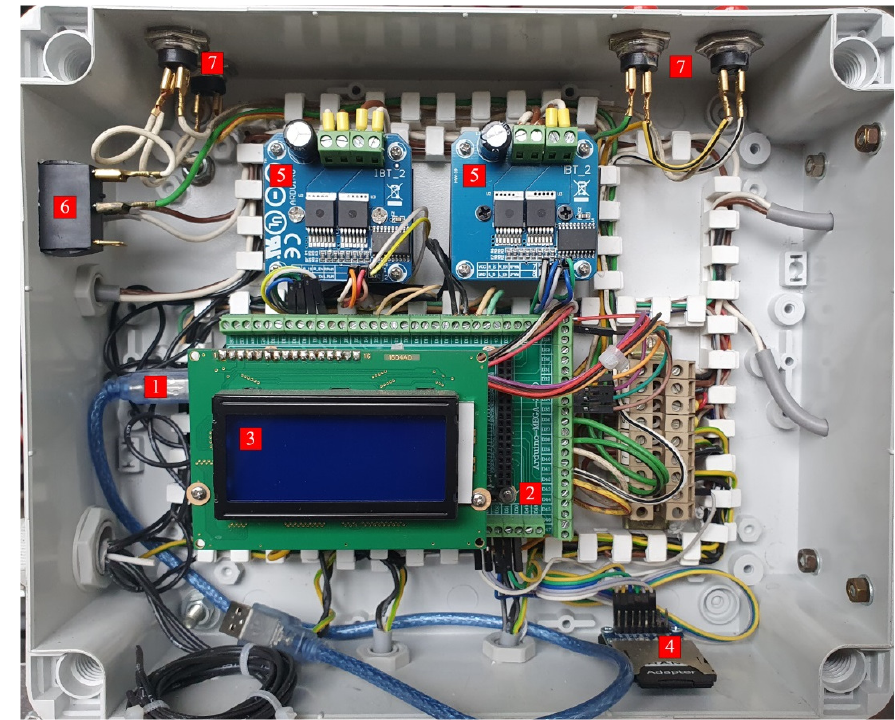
Figure 5. An image of the electronic circuit made for the solar tracker. 1 – visible USB connection to the Arduino Uno main board, 2 – Arduino MEGA, 3 – display panel, 4 – SD Card memory slot, 5 – motor controllers, 6 – main power switch, 7 – calibration and manual control